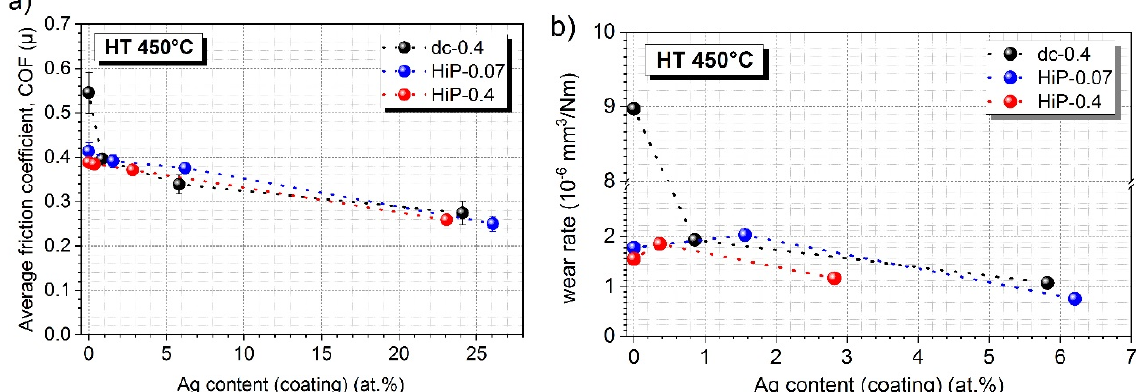
Figure 13. Friction coefficient ( a ) and wear rate ( b ) of MoN-Ag coated steel vs. Ag content of pin-on-disc tests at 450 °C (30,000 rotations). Notice: the y axis is interrupted between the numbers 3 and 8.